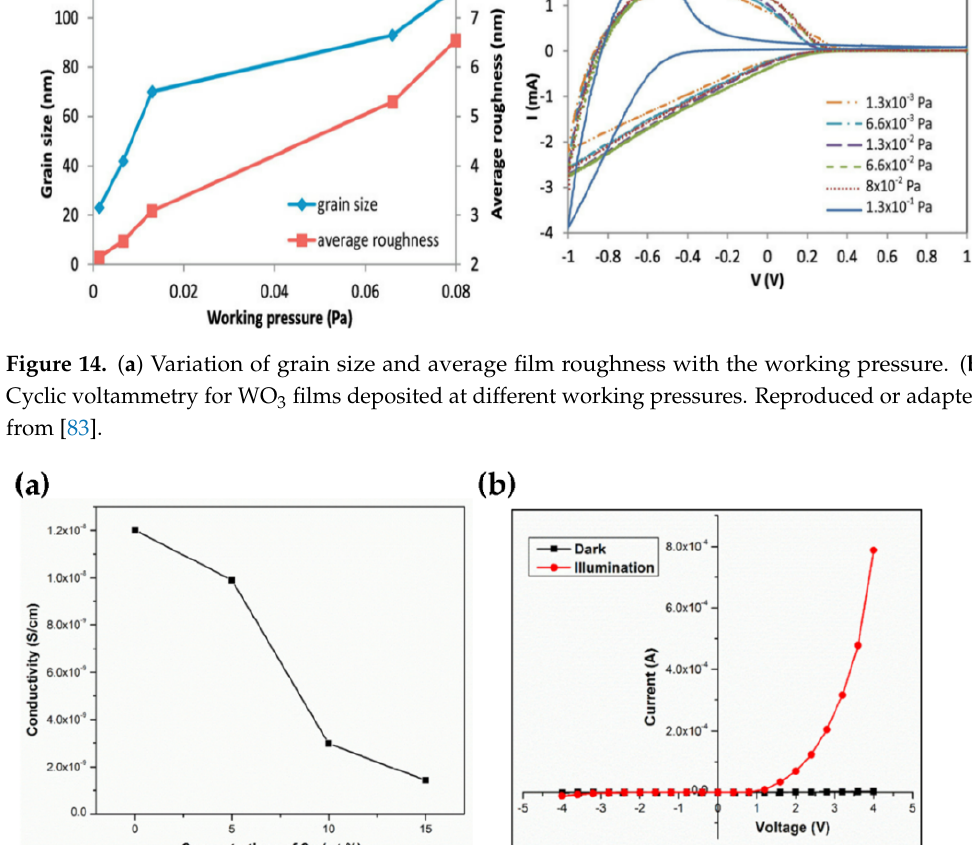
Figure 14. ( a ) Variation of grain size and average film roughness with the working pressure. ( b ) Cyclic voltammetry for WO 3 films deposited at different working pressures. Reproduced or adapted from [83].